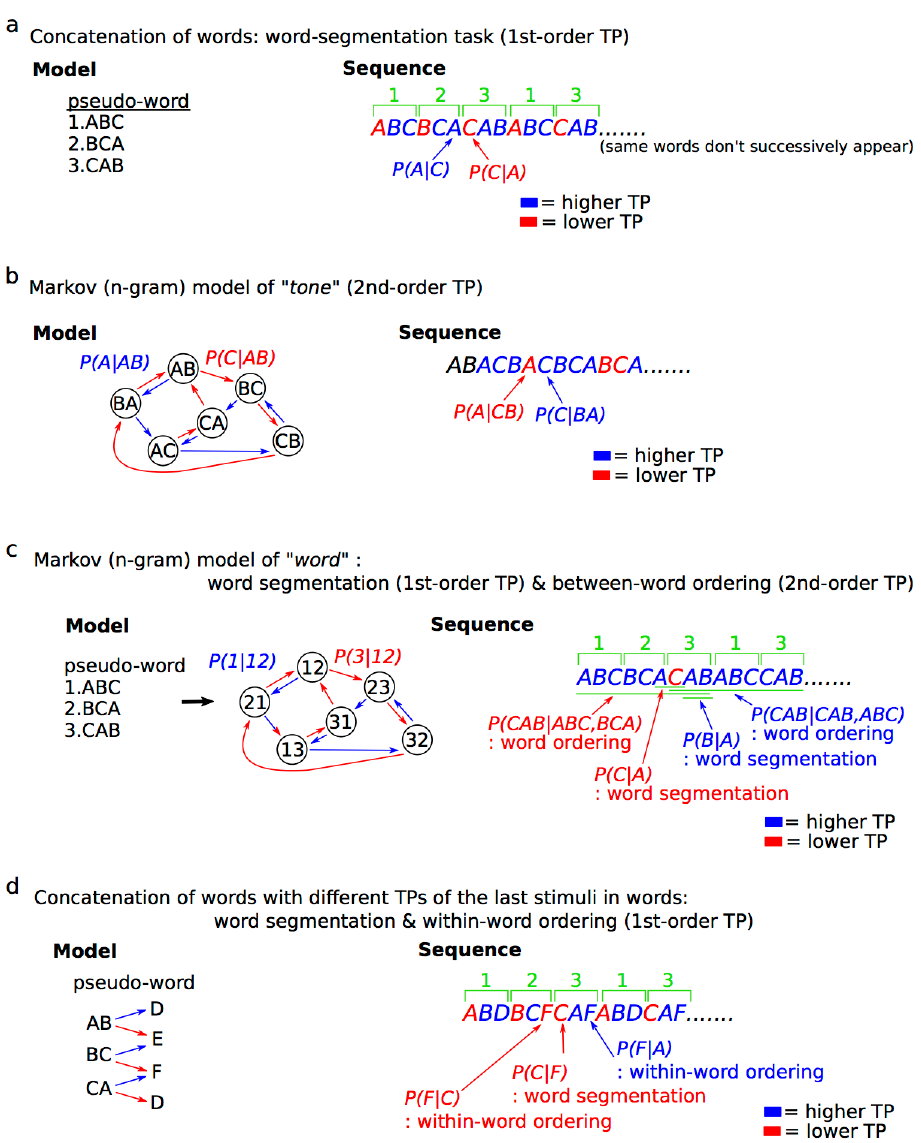
Figure 2. SL models and the sequences used in neural studies. All of the models and paradigms in sequences based on concatenation of words ( a ), Markov model of tone ( b ) and word ( c ), and concatenation of words with different TPs of the last stimuli in words ( d ) are simplified so that the characteristics of paradigms can be compared. In the example of word-segmentation paradigm ( a ), the same words do not successively appear. TP — transitional probability.